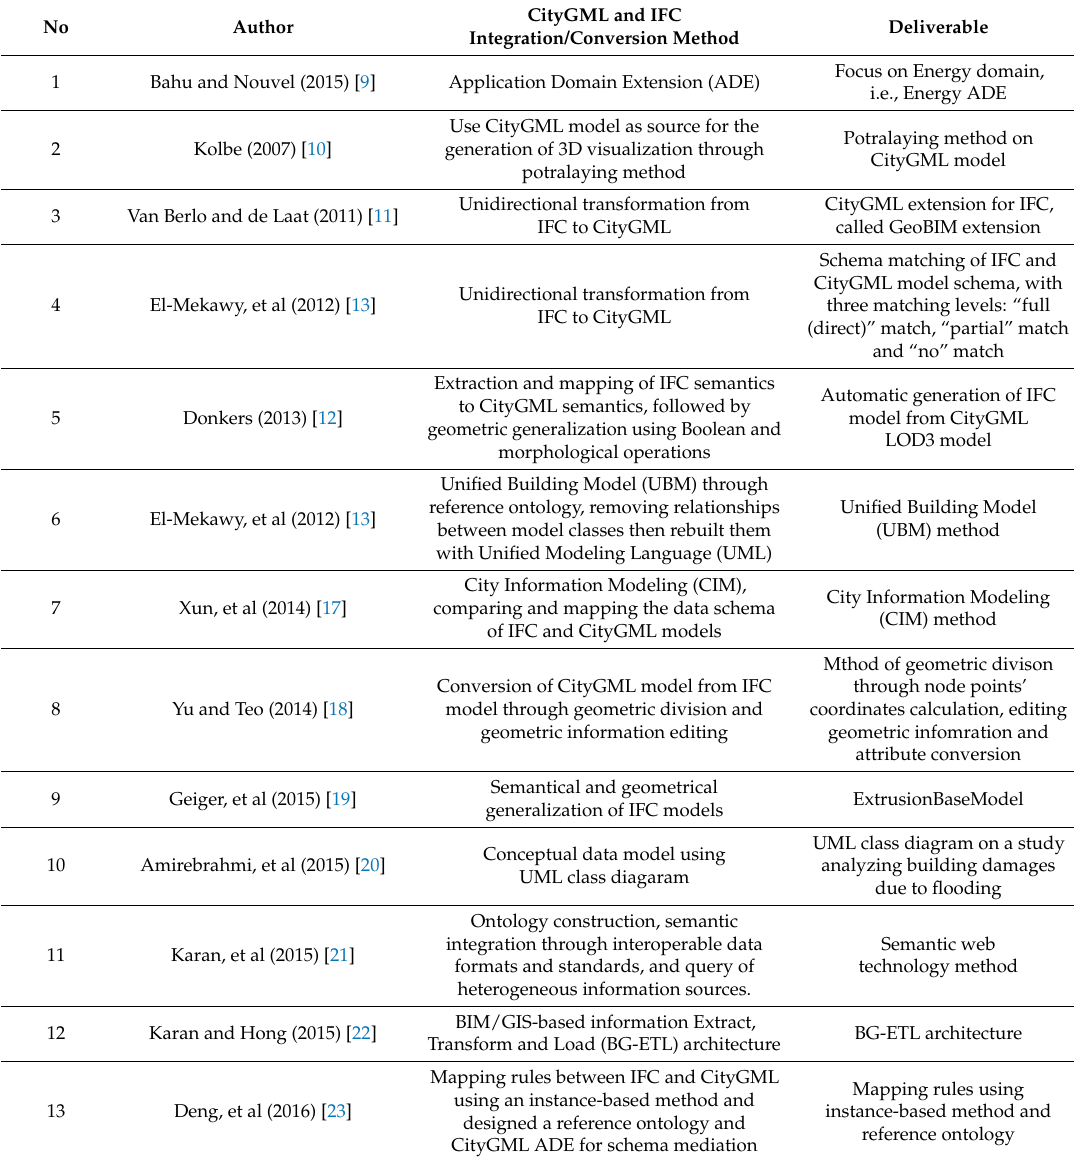
Table 2. Summary of literature